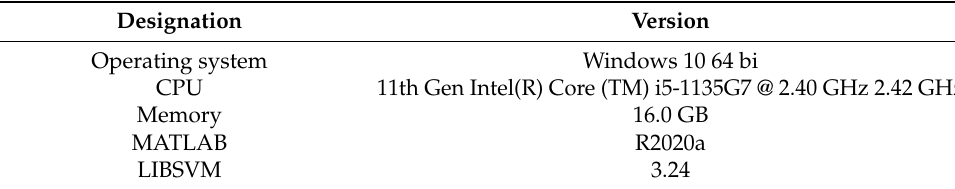
Table 3. Experimental environment